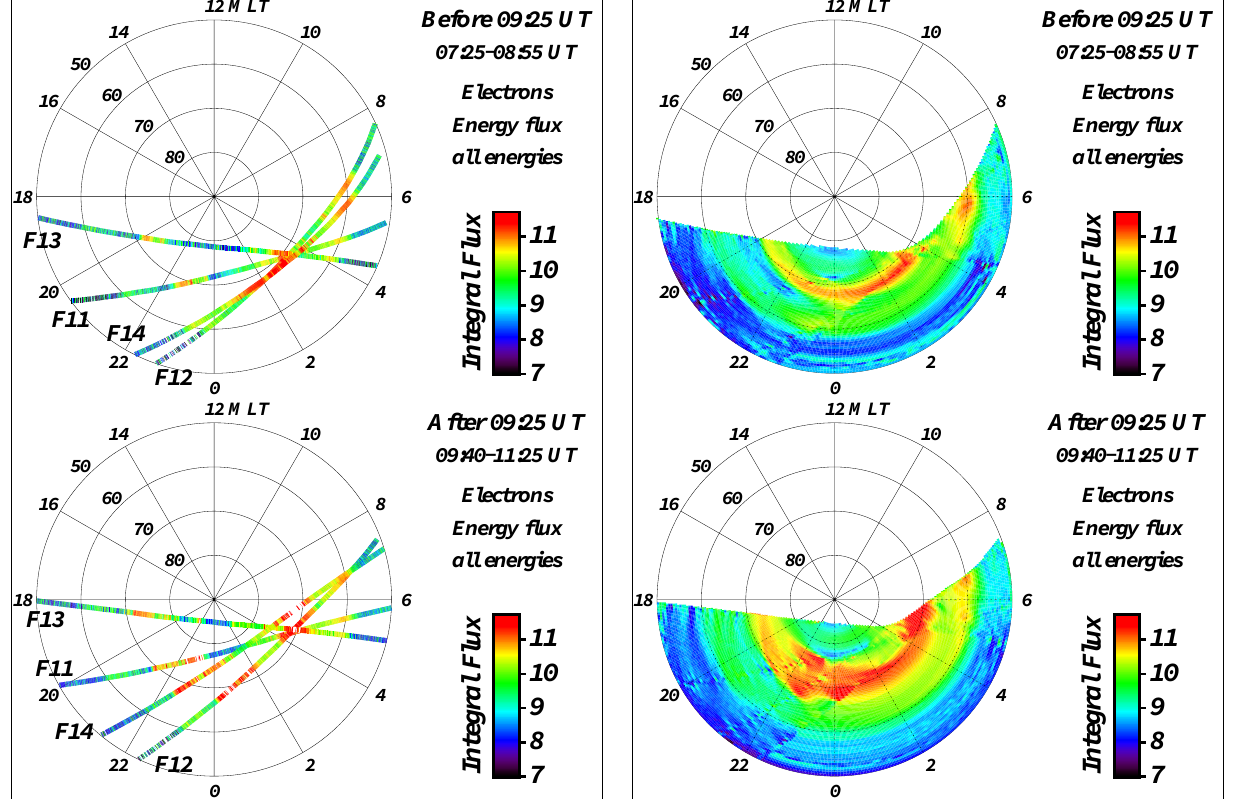
Fig. 7. DMSP electron integral energy fluxes for the Southern Hemisphere on 30 April 1998. The two panels on the left are the actual measurements before (top) and after (bottom) the solar wind pressure front. The panels on the right are two-dimensional interpolations of the trace fluxes on the left. An intensification and poleward expansion of the aurora are clearly observed.